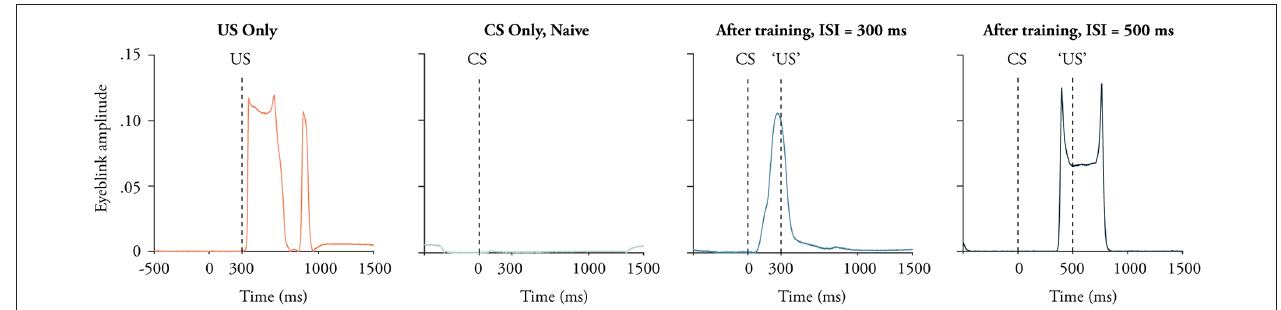
FIGURE 1 | Examples of eye-movements in response to the conditional stimulus (CS) and the unconditional stimulus (US). Presenting only the US elicits a short latency blink reflex (red). Before training the CS elicits no response (green), but after approximately 100 trials the same stimulus elicits a conditional blink response whose peak approximately matches the interstimulus interval (ISI). The exact shape of the traces depends on the position of the magnet and the GMR sensor. This explains why the trace to the right has two peaks even though the trace next to it does not.